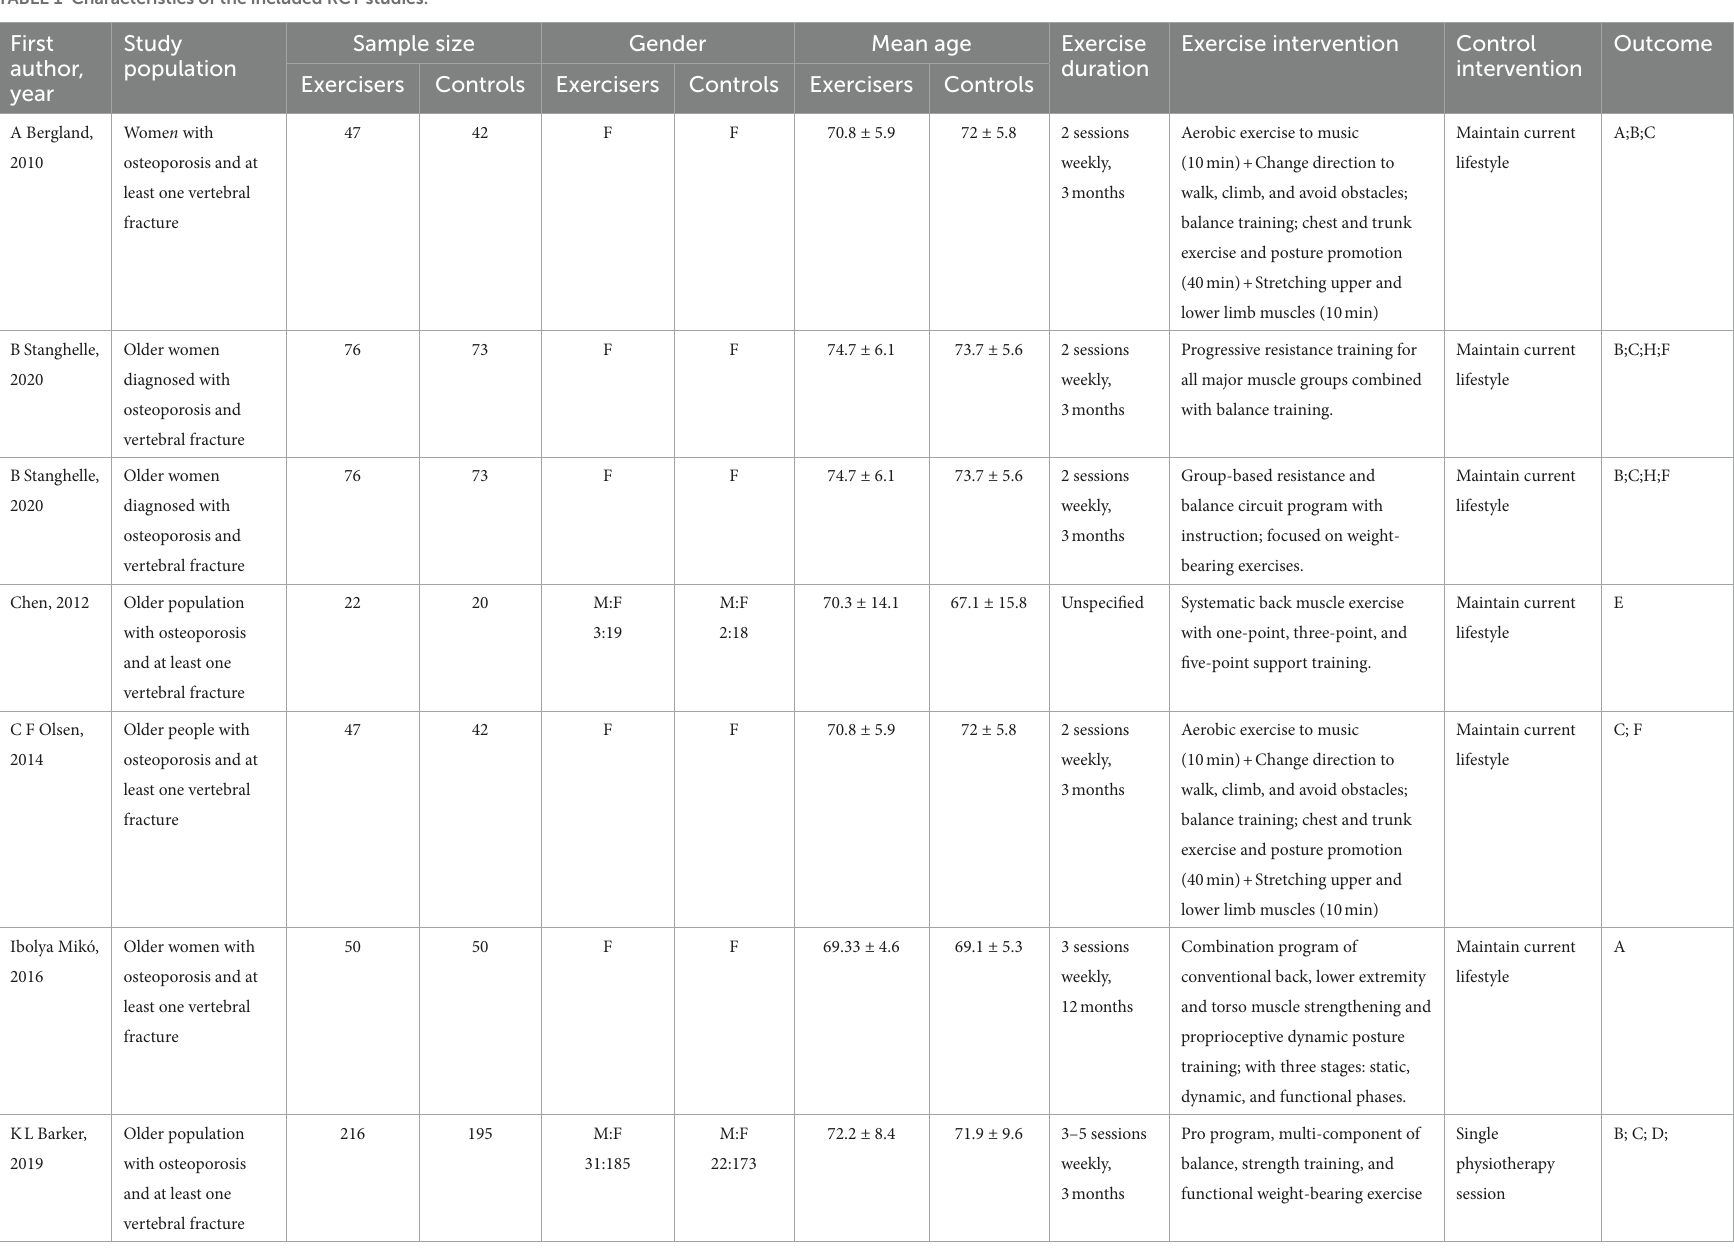
TABLE 1 Characteristics of the included RCT